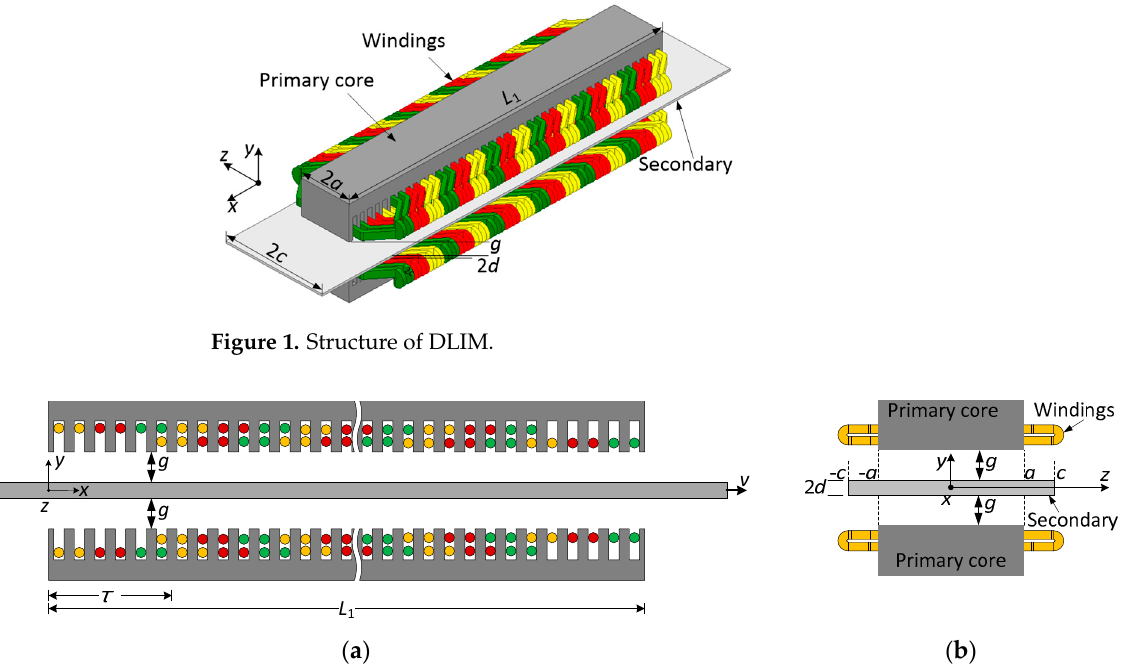
Figure 2. Analytical model of DLIM: ( a ) longitudinal model in the XOY plane; ( b ) transverse model in the YOZ plane.